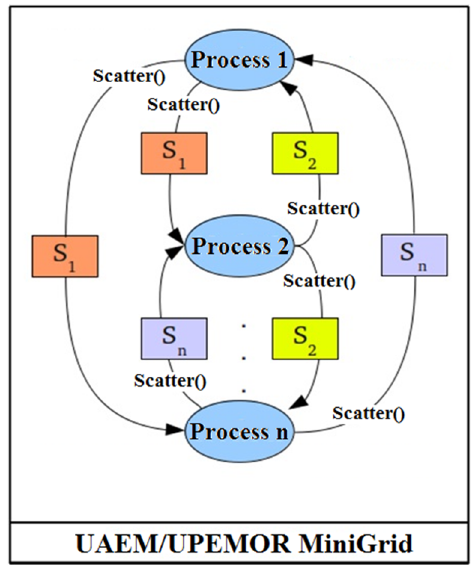
Figure 7. Sending mutated segments of the population to all processes in MiniGrid.